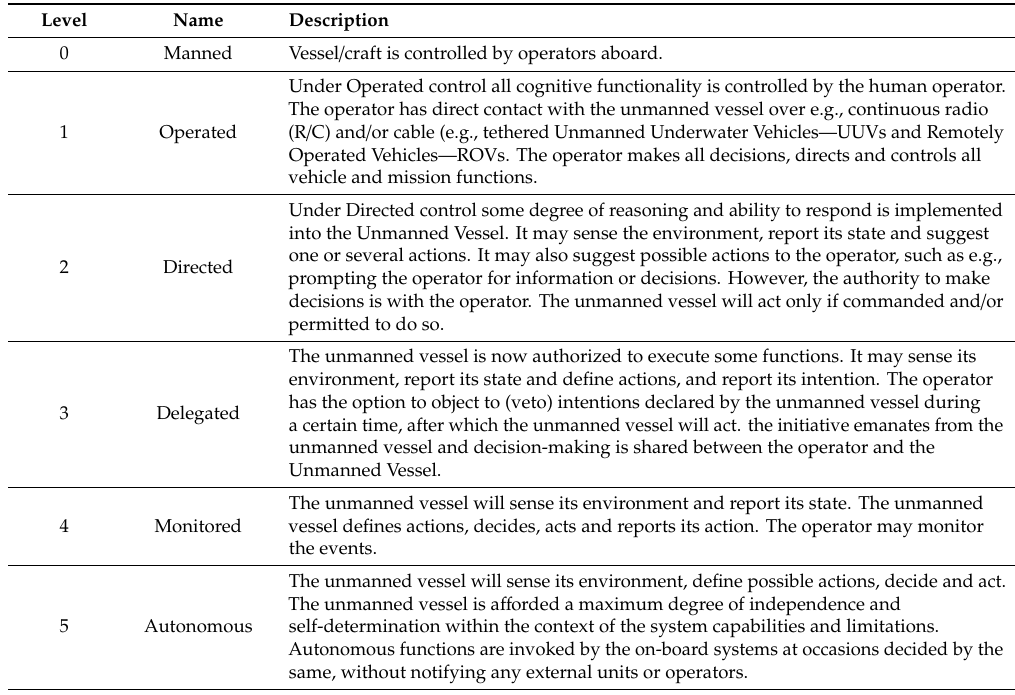
Table 1. Maritime Autonomous Surface Ships (MASS) Level of Control Definitions according to the ‘MASS UK Code of Practice’